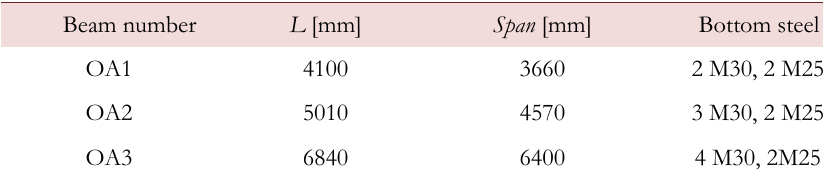
Table 2: Detail of beams.